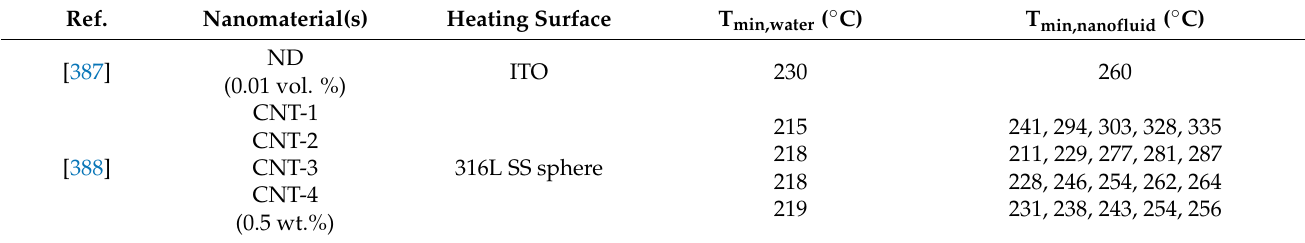
Table 9. Summary of selected T min enhancement for various pool boiling studies in water based nanofluids.